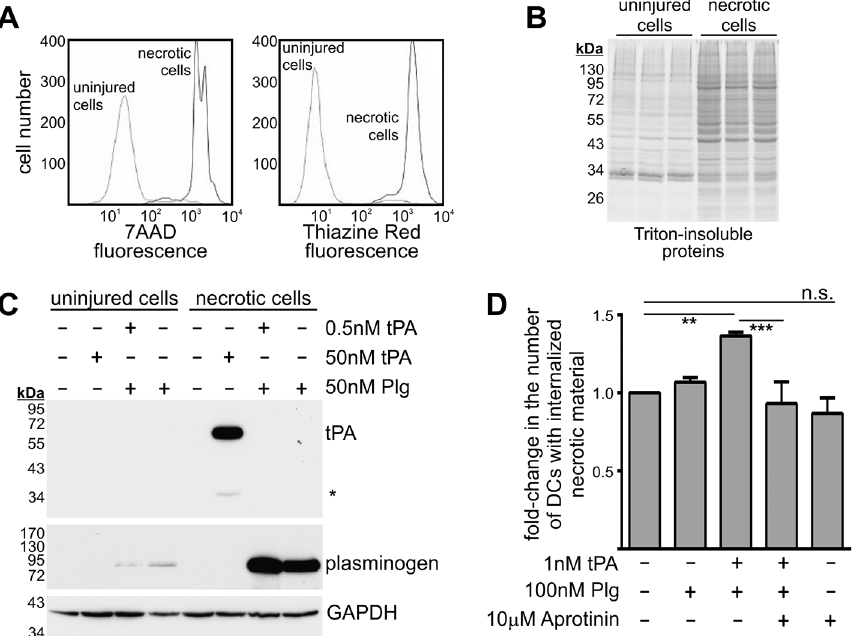
Fig 1. Necrotic cells harbour misfolded proteins and generate surface-bound plasmin which increases their phagocytosis by human MoDCs. (A) Uninjured and necrotic Jurkat lymphocytes were stained with 10 mg/L 7AAD and 10 mg /L Thiazine Red for 15 min then subjected to flow cytometry. (B) The Triton-insoluble fractions of uninjured and necrotic Jurkat lymphocytes were subjected to SDS-PAGE under reducing conditions and subsequent Coomassie staining. (C) Uninjured and necrotic Jurkat lymphocytes were incubated with t-PA and/or plasminogen for 15 min and washed. Total cellular protein lysates were prepared and subjected to SDS-PAGE under reducing conditions and subsequent immunoblot analysis. Most of the t-PA used was in single-chain form (~70 kDa), however a small extent of two-chain t-PA was also apparent (the band indicated by the asterisk at ~35 kDa). (D) PKH67-labelled necrotic Jurkat lymphocytes were treated with the indicated reagents for 15 min, then washed and incubated with PKH26-labelled